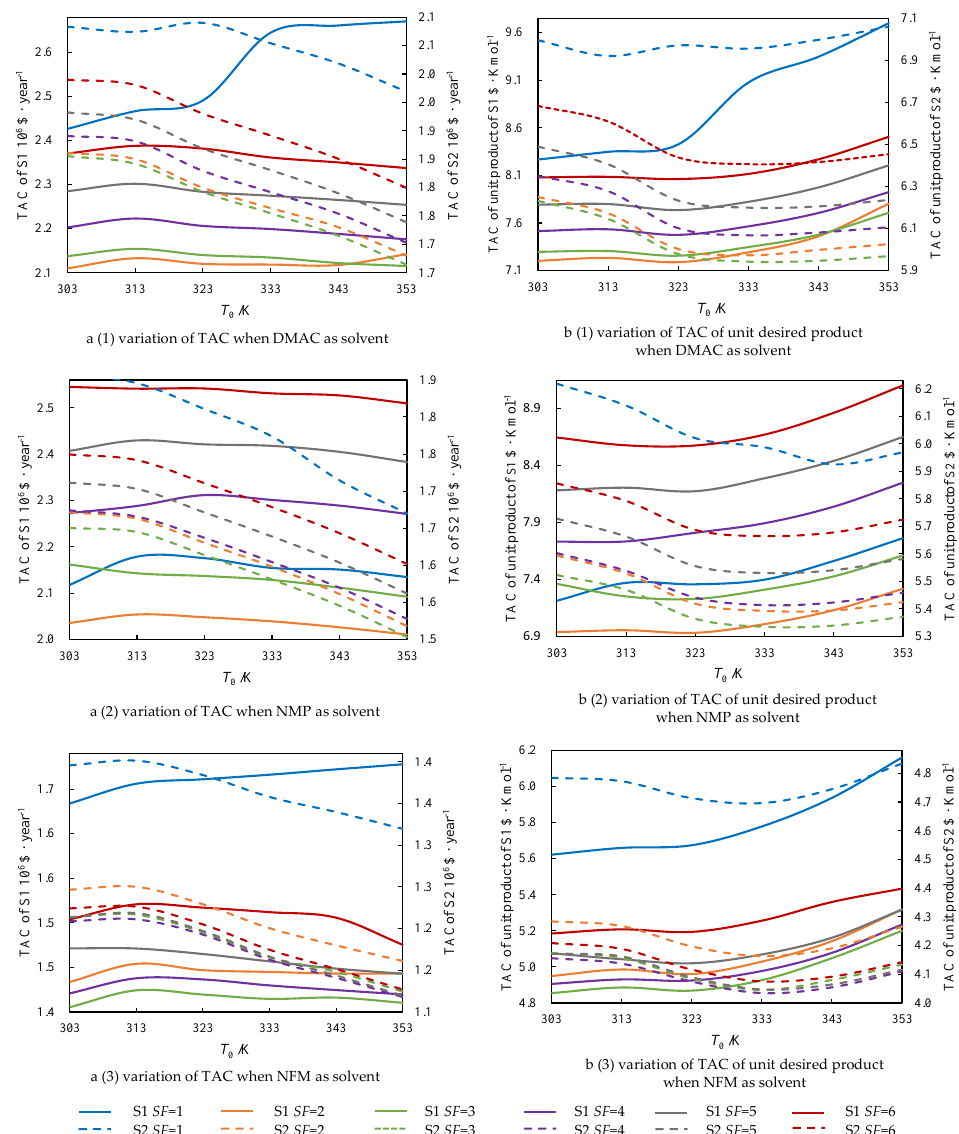
The feed of the extractive distillation system includes three components (excludes the solvent), the corresponding non-key component matrix shown by Equation (14) can represent the possible extractive distillation sequences. Herein, A 1 , A 2 , A 3 represent HA, HE and BZ, respectively. Based on this and with the solvent considered, sequence 1 (S1) and sequence 2 (S2) are identified, and their flowsheets are the same as those shown in Figure 1. Since the solvents of two extractive distillation columns are the same, the first solvent recovery column of S1 is taken out. For sequences S1 and S2, the TACs and TACs of unit desired product of the system are calculated according to the procedure introduced in Section 4, and are plotted in Figure 9. When the solvent-to-feed ratio increases, the TAC and TAC of unit desired product decrease first and then increase, no matter which solvent is used. For S1, when DMAC is used and the reactor’s inlet temperature lies in 303~343 K, the minimum TAC is obtained when the solvent-to-feed ratio equals 2, while the solvent- to-feed ratio corresponding to the minimum TAC is 3 when the feed inlet into the reactor is at 353 K. When NMP is used, the solvent-to-feed ratio with minimum TAC is equal to 2, while it is 3 when NFM is the solvent. For S2, the solvent-to-feed ratio with minimum TAC is equal to 3 when DMAC and NMP are used at all of the reactor’s inlet temperatures, while it is 4 when NFM is used.